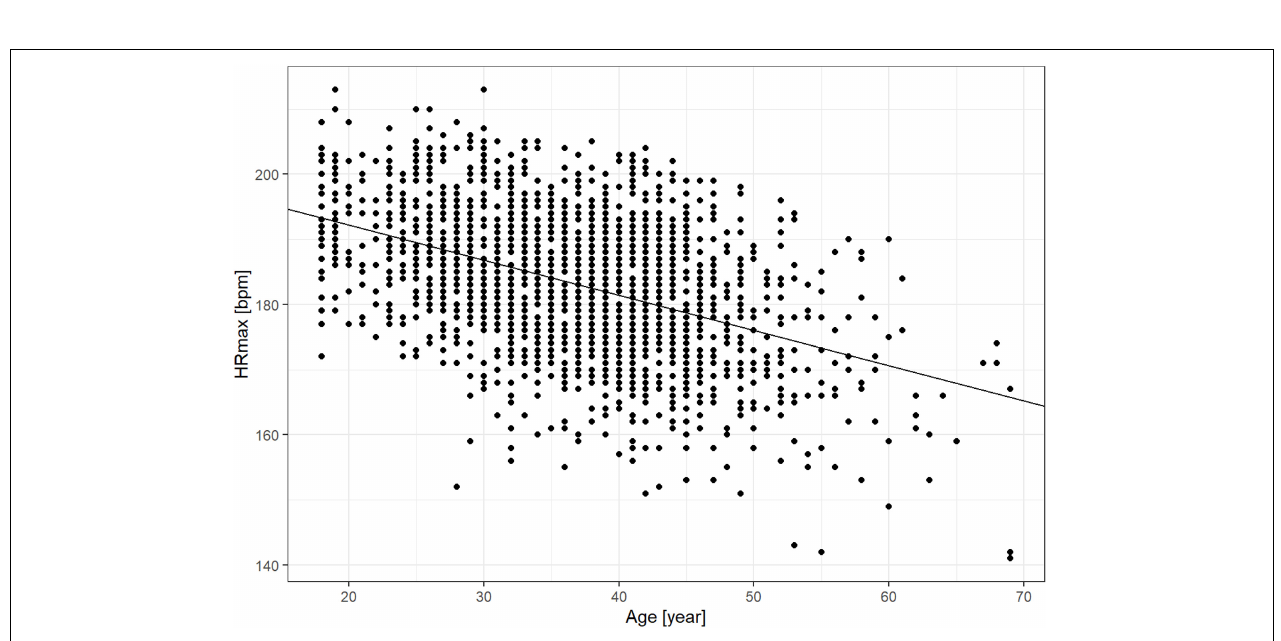
FIGURE 2 | Univariate linear regression of maximum heart rate (HRmax) and age (202.5–0.53*age; R 2 = 0.198).